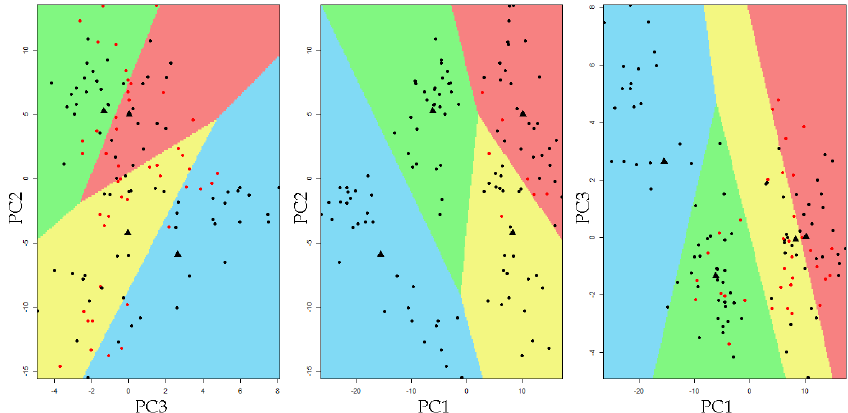
Figure 6. Partition plot resulting from the linear discriminant analysis in the 3D principal component space. The colors set the limits of each classification area defined by the LDA model (blue = sound, green = mild, yellow = moderate, and red = severe). The black marks indicate the sample was correctly classified, while red marks indicate the sample was incorrectly classified by the model. The black dots represent the group mean